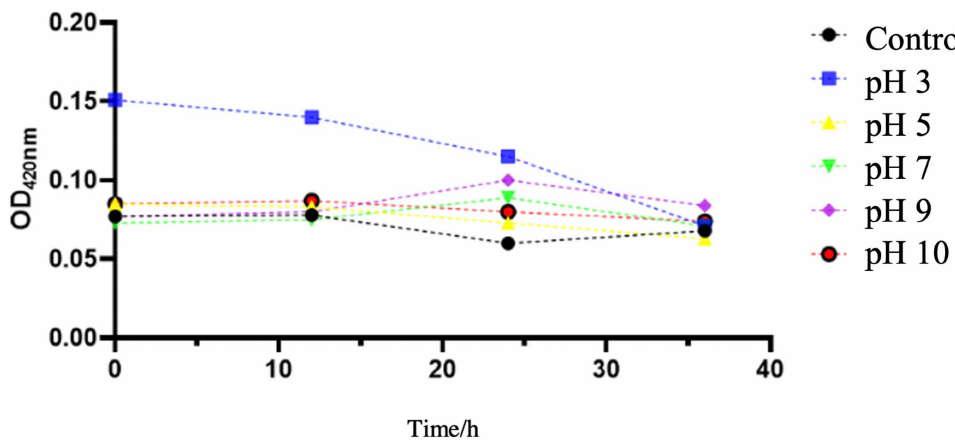
Figure 9. Effect of different pH on sedimentation of